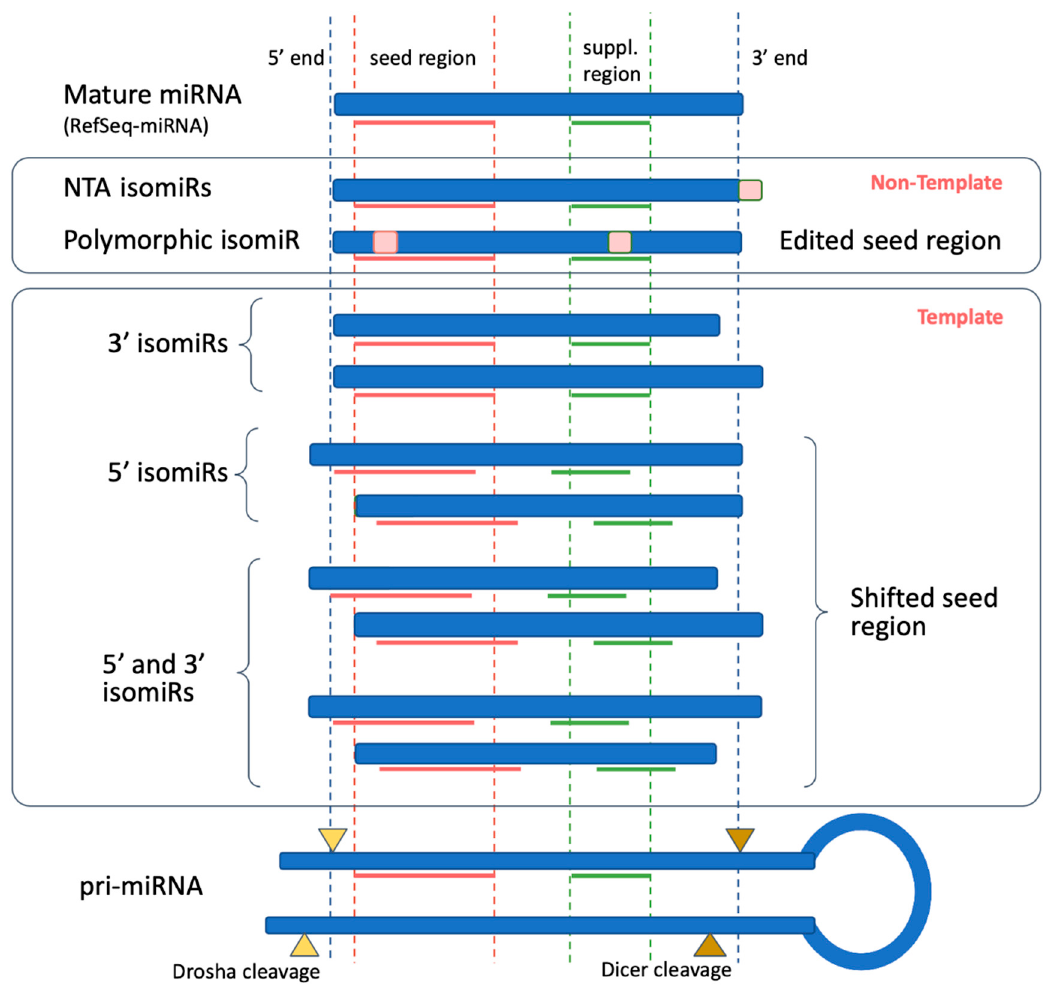
Figure 1. Length and sequence variations of isomiRs associated with the mature microRNA (miRNA) sequence (reference sequence, RefSeq) in miRBase.